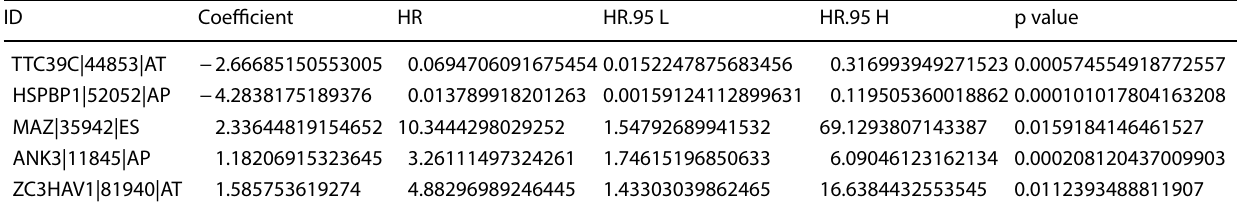
Table 1 The regression coefficient of 5 AS events in the breast cancer risk